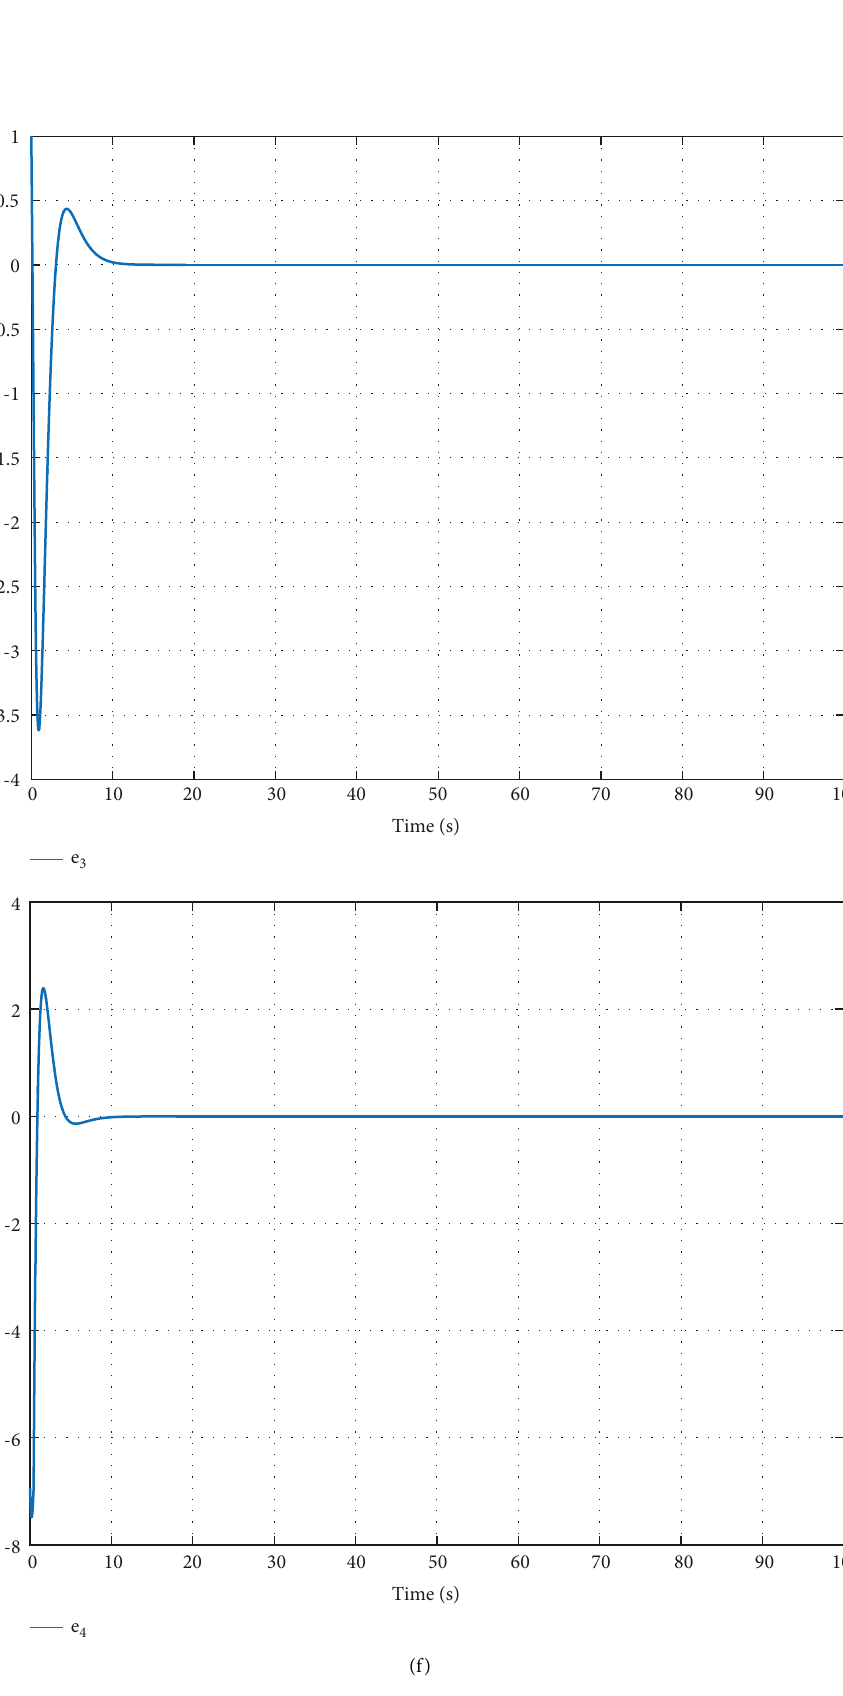
( 0 ) , y ( 0 ) � ( 2 , − 1 )] . (d) Anti- 3 3 ( 0 ) , y ( 0 ) � (− 3 , − 4 )] . (e), (f) Time history of the errors 4 4